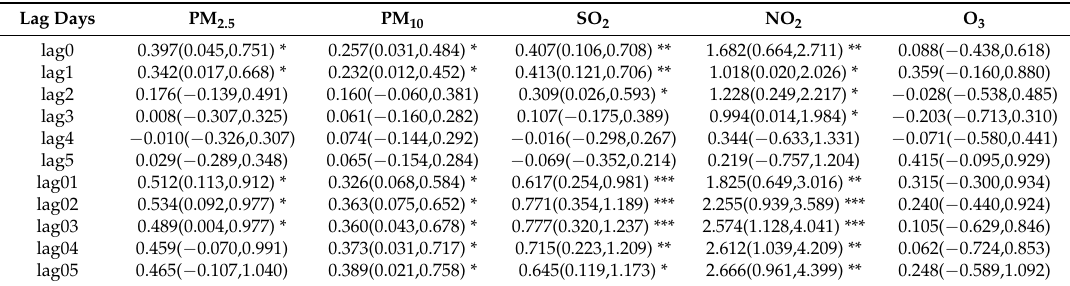
Table 3. The percent change and 95% CI for respiratory disease hospitalization associated with a 10- µ g/m 3 increases in air pollutants concentrations in single-pollutant models. PM